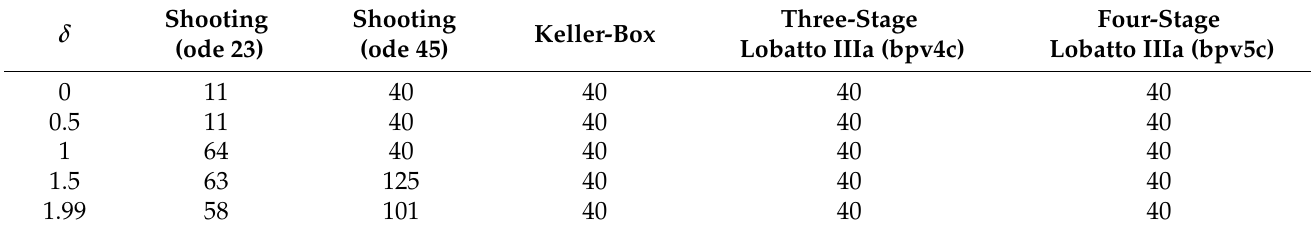
Table 9. Number of bondes for each numerical